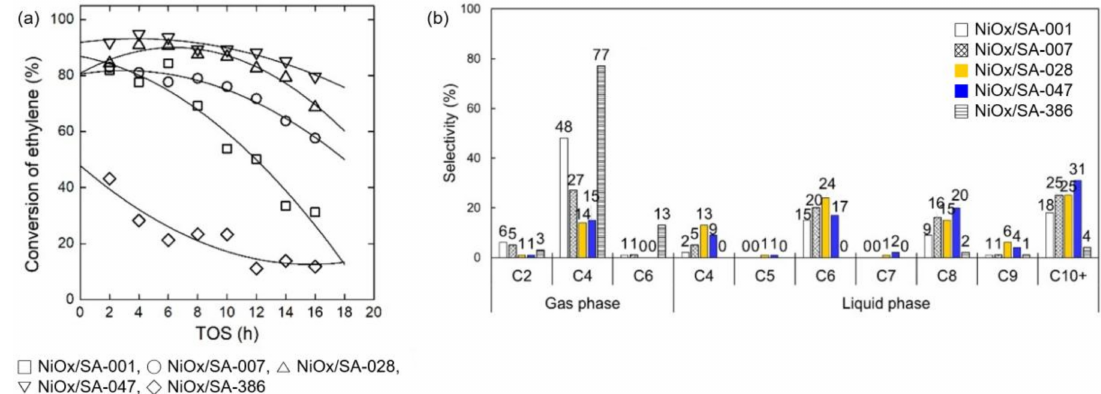
Figure 6. ( a ) Ethylene conversion as a function of time on stream (TOS) over NiOx / SA-001, NiOx / SA-007, NiOx / SA-028, NiOx / SA-047, and NiOx / SA-386 at 00 ◦ C, 10 bar, and 0.375 h − 1 WHSV and ( b ) selectivity to products of gas (C2–C6) and liquid phases (C4–C10 + ) obtained after 16 h on stream.